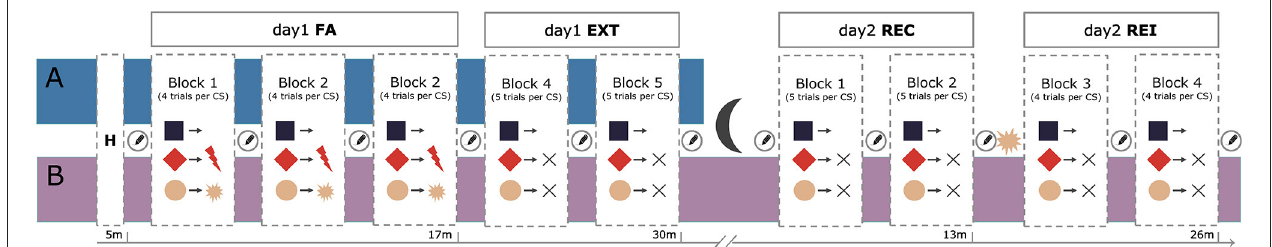
FIGURE 1 | Experimental procedure of the fear-conditioning task. Sample (A) underwent a habituation phase, three blocks of fear acquisition (FA) and two blocks of extinction (EXT) on day 1. Sample (B) additionally underwent a two-block fear recall (REC) and two-block reinstatement (REI) procedure on day 2. All blocks were separated by US-expectancy